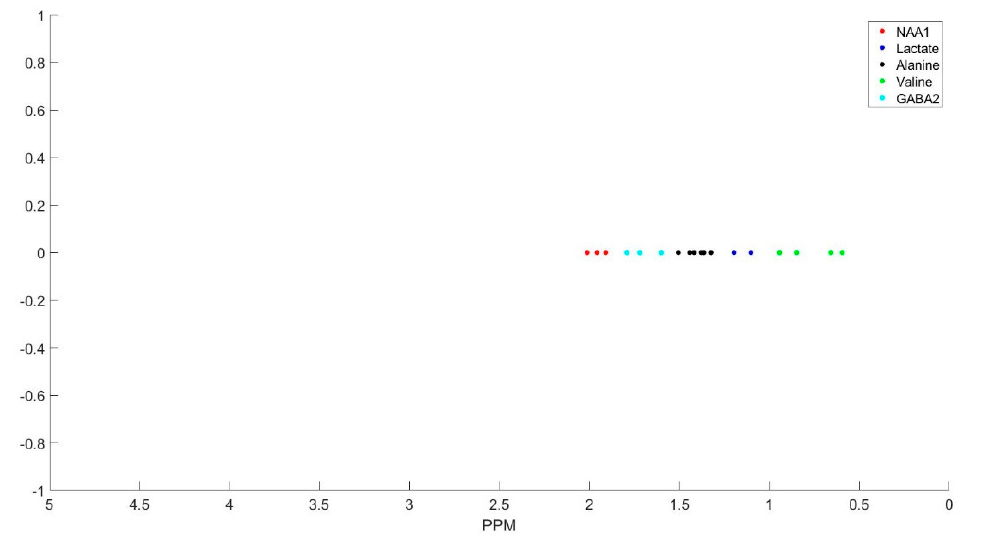
Figure A2. Metabolites listed as group 1 and their corresponding Figure 7. Metabolites listed as group 1 and their corresponding peaks. Figure 7. Metabolites listed as group 1 and their corresponding peaks.